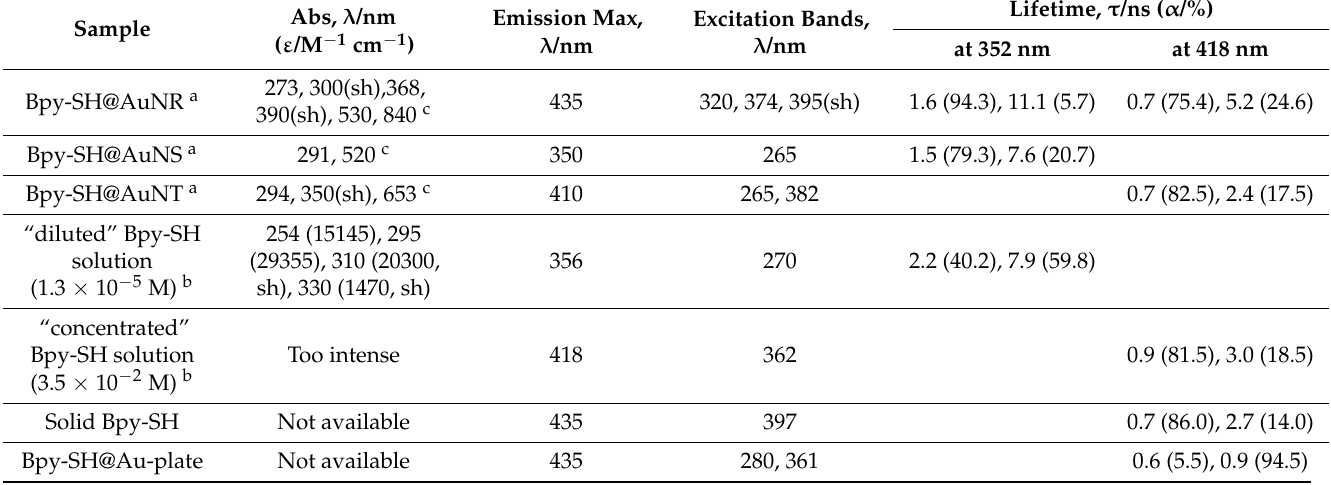
Table 1. Photophysical properties of investigated